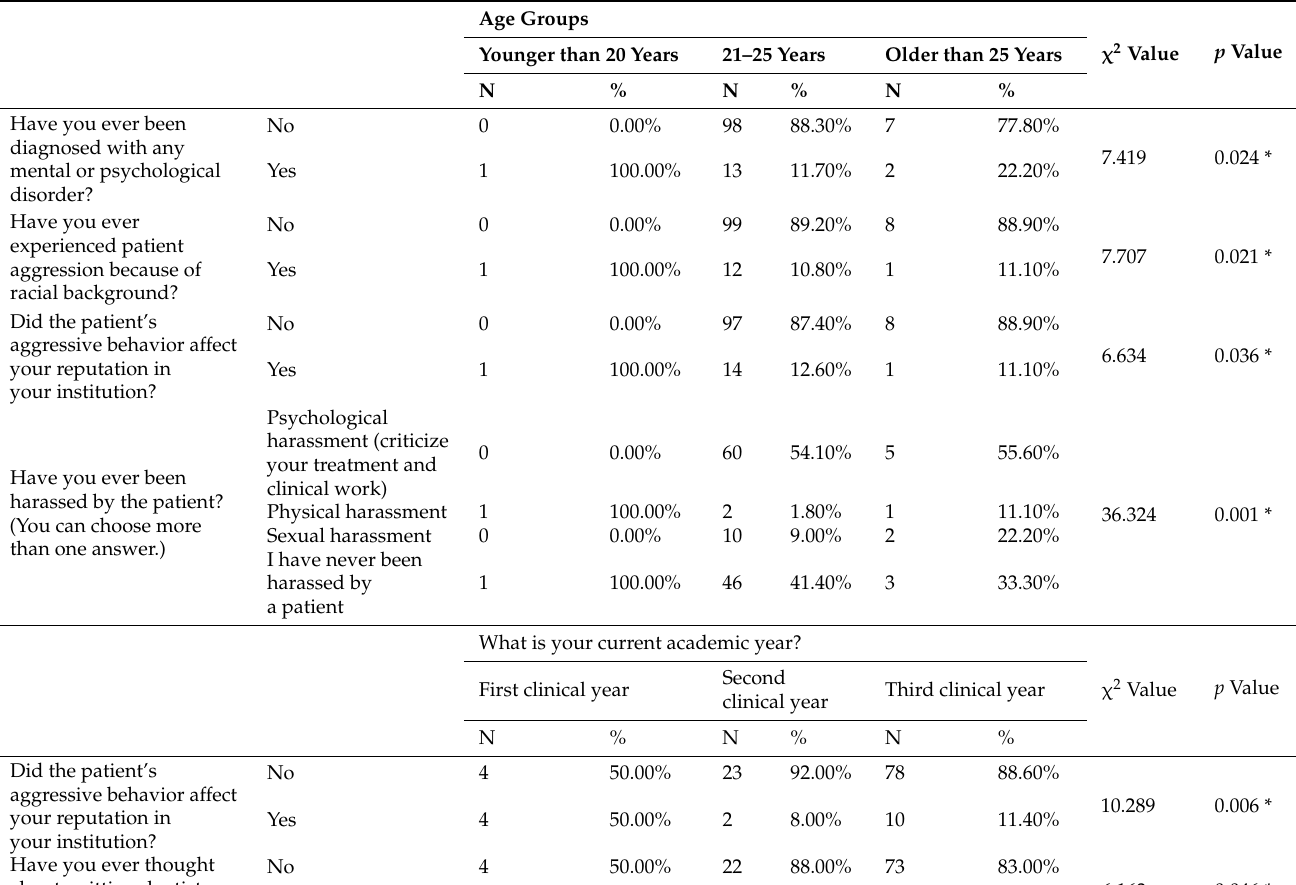
Table 5. Association between patient aggression and clinical years and age